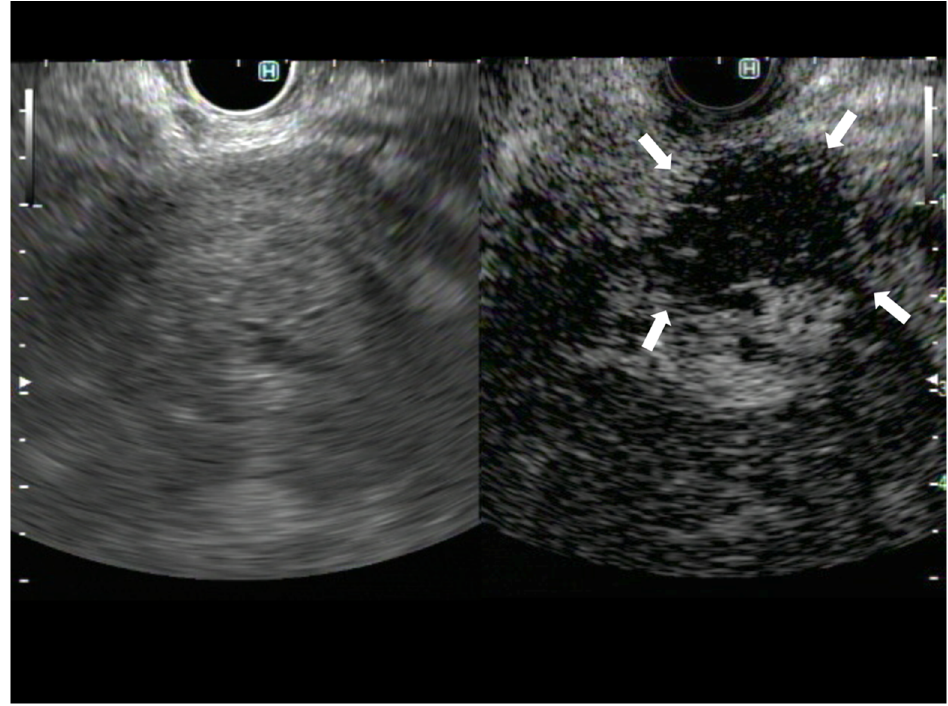
Figure 2. A case of pancreatic adenocarcinoma. The image on the left shows B-mode EUS, and the image on the right shows CH-EUS. The avascular area observed in the CH-EUS image was not identified on B-mode EUS (arrows).